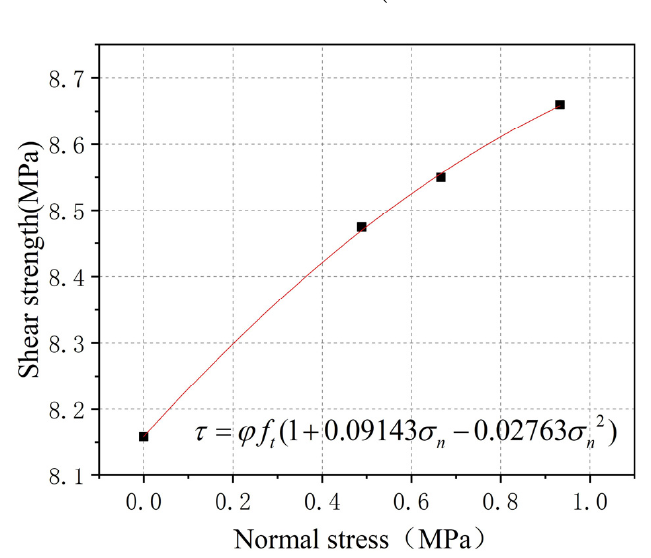
Figure 11. Fitting curve diagram.